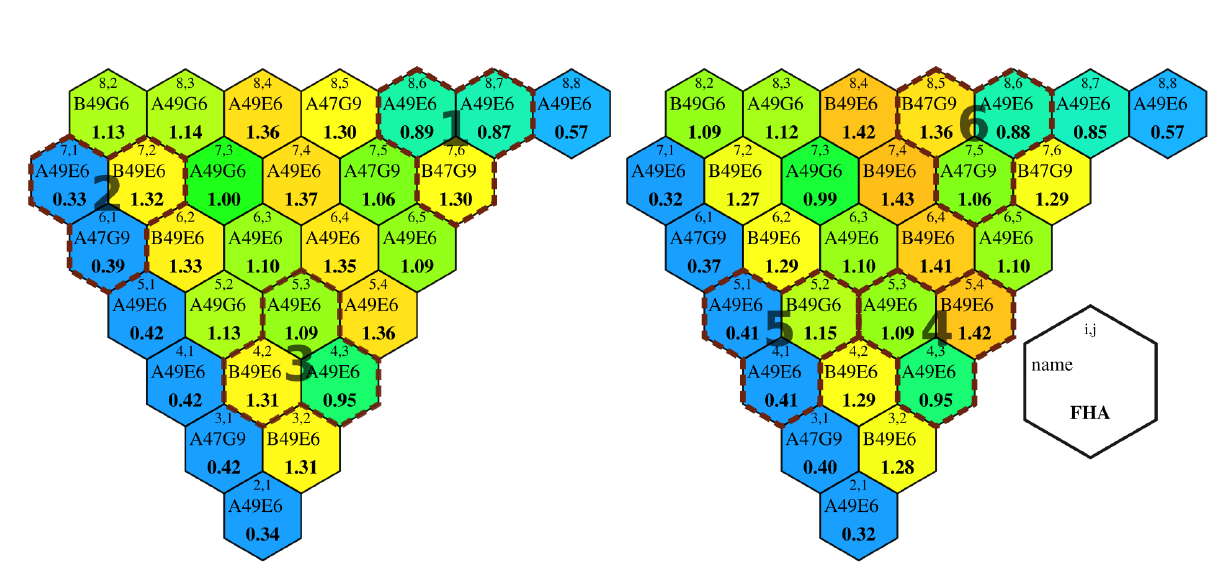
Figure 4. Calculated power profiles T1 and T2. [4]